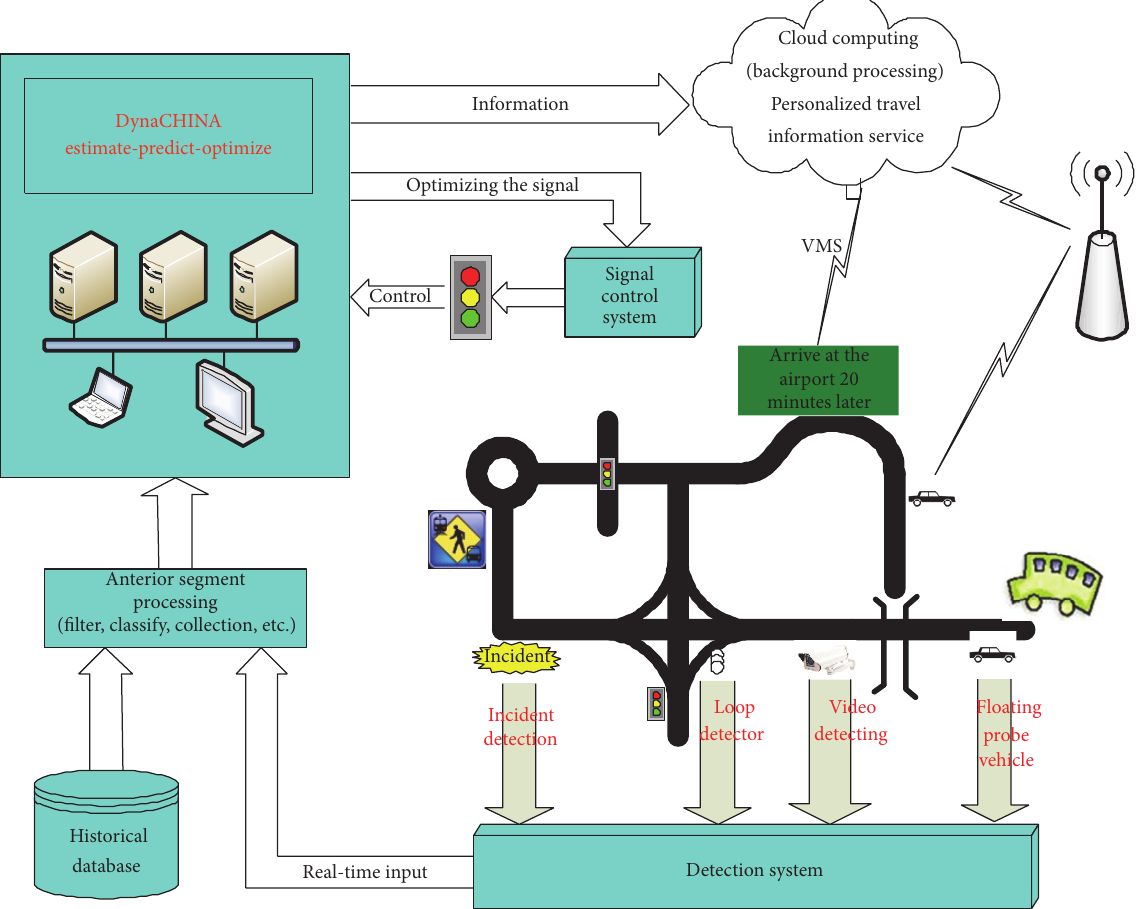
Figure 1: DynaCHINA system